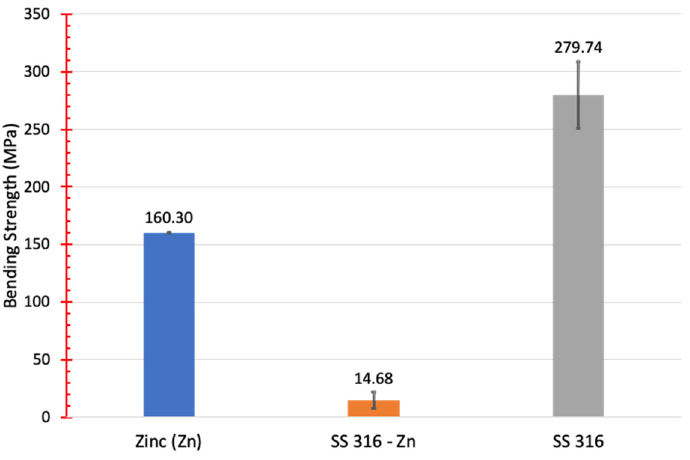
Figure 6. Bending strength of SS 316-pure Zn joints (friction time of 35 s) with base